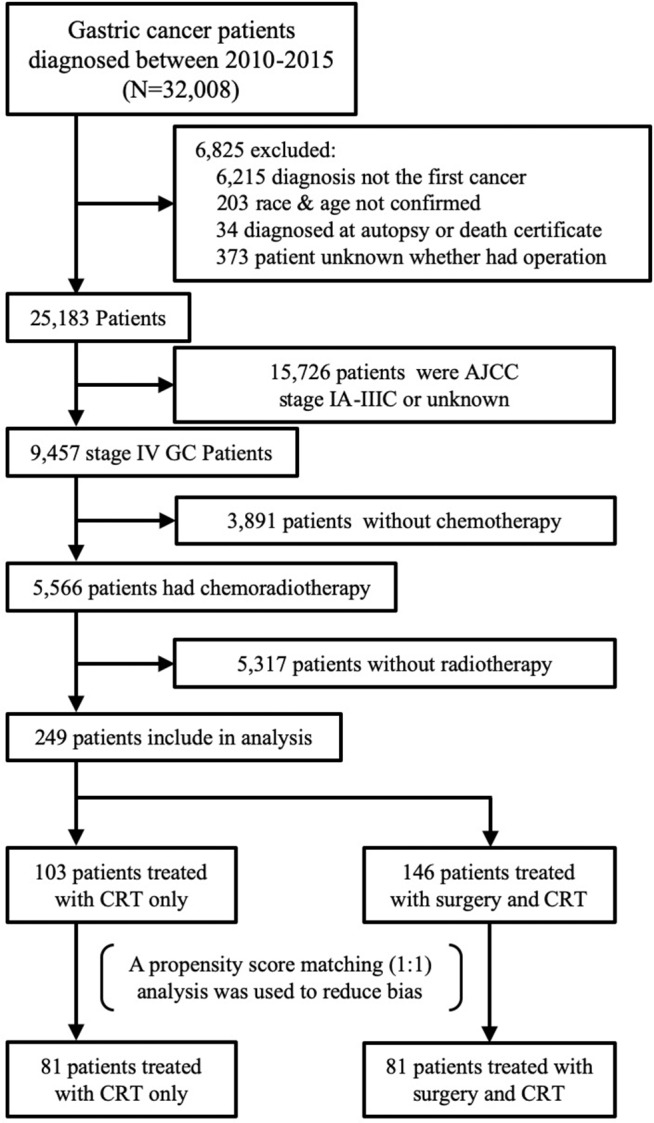
Flowchart of data extraction from SEER database.